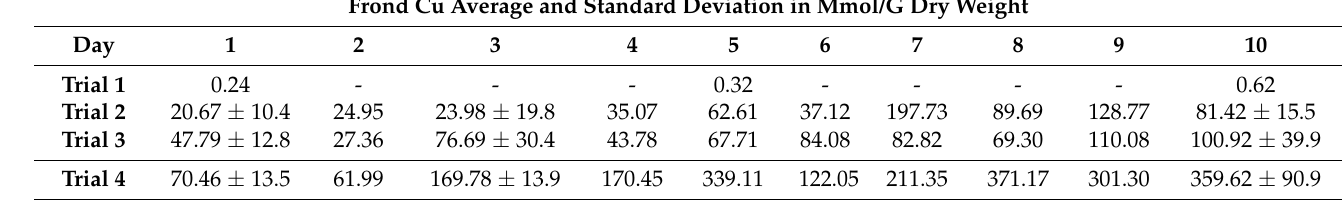
Table 2. Cu measured in moss fronds μmol/g dry wt. based on 3 frond pairs sampled after each treatment for each day in the experiment. Days 1, 3, and 10 show Cu averages with standard deviation for all 3 frond pairs per trial. The other days only have 1 frond pair that was analyzed so no standard deviation. Trial 1 only has data available for 1 frond pair on days 1, 5, and 10. Frond Cu Average and Standard Deviation in μmol/g dry weight